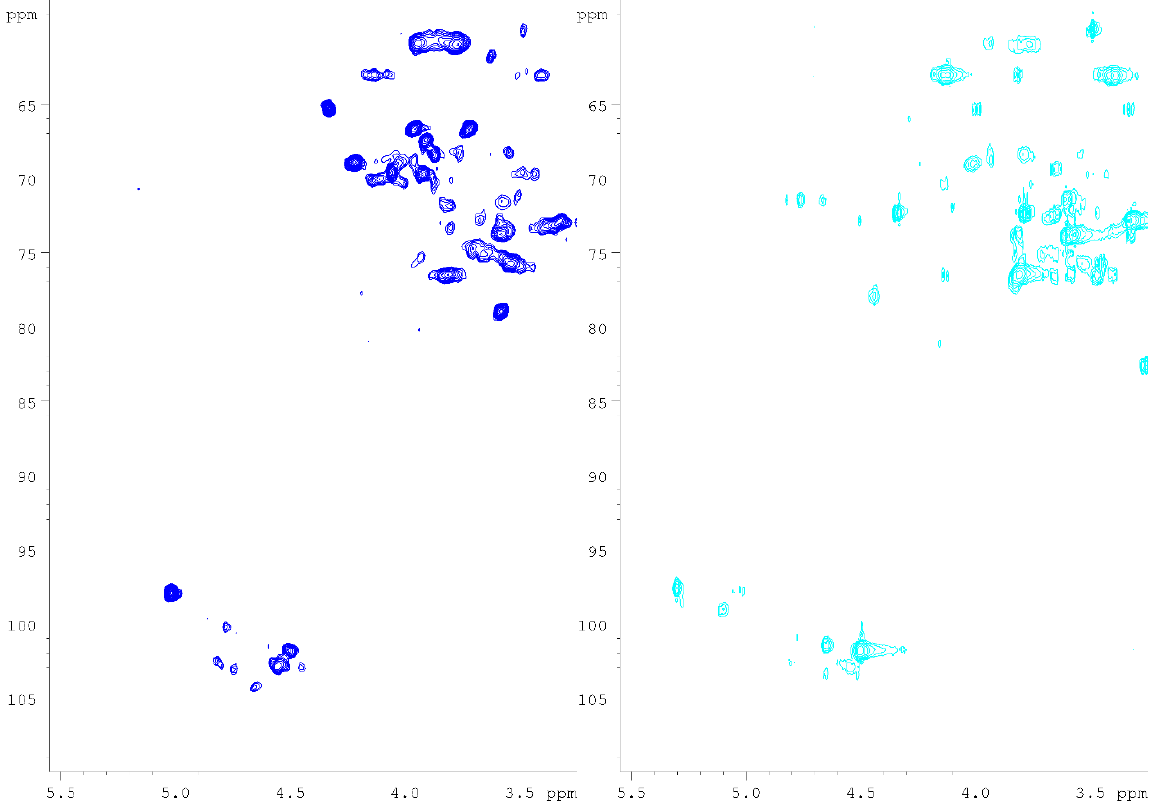
Figure 4. HSQC spectra of Heart Rot HW (blue) and Heart Rot 2% (light blue). NMR spectra were recorded in D 2 O at 308 K. See Table 3 for signal assignments. Table 3. 13 C and 1 H chemical shifts (ppm) for the polysaccharides extracted from birch heart rot caused by I. obliquus . Fraction